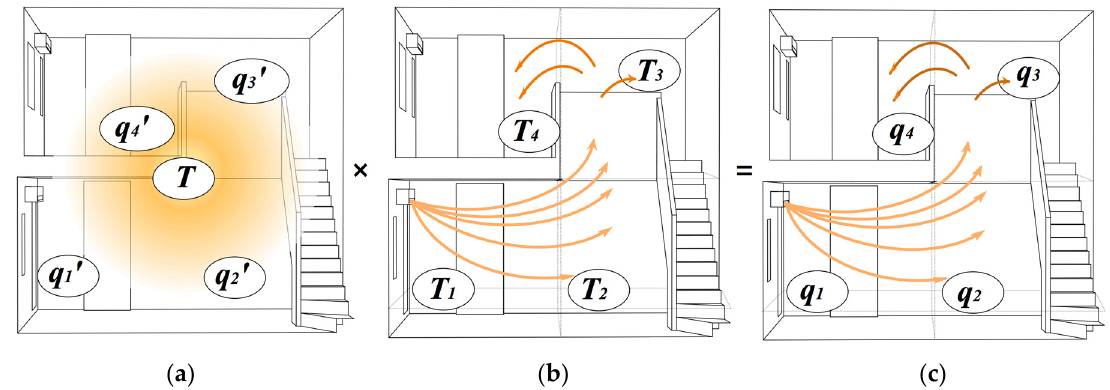
Figure 2. Conceptual diagram of coupled analysis with calorimetric correction: ( a ) air conditioning load of each room; ( b ) temperature distribution (computational fluid dynamics); ( c ) heat input to each room.